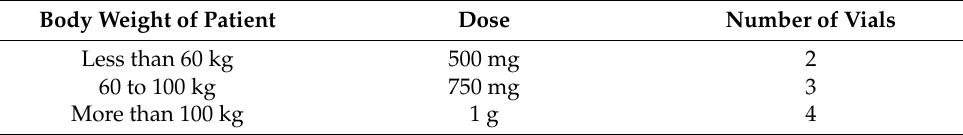
Table 1. Treatment regimen using the study drug.